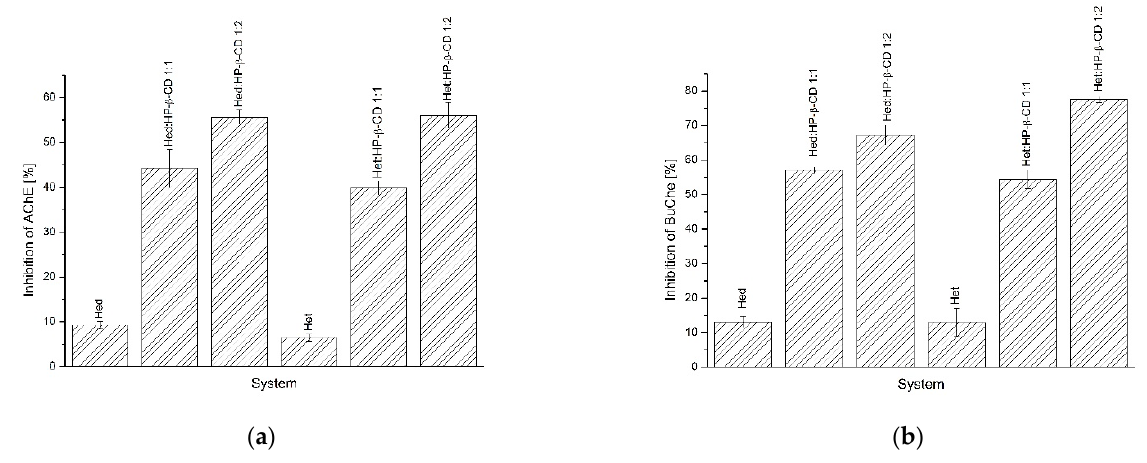
Figure 8. The results of AChE ( a ) and BChE ( b ) inhibition assays of Hed and Het systems with HP- β -CD.